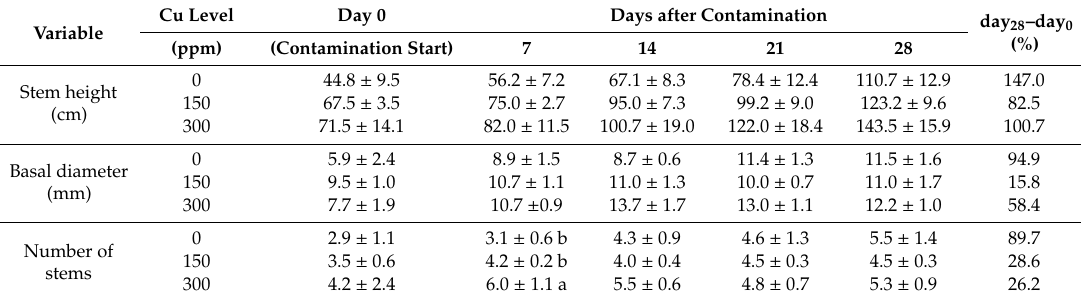
Table 2. Time course of the plant height (main stem length), the number of stems and the basal diameter of the main stem in Arundo plants treated with di ff erent copper concentrations (0, 150, and 300 ppm) for 28 days. The values represent means (n = 4) ± S.E., respectively. One-way ANOVA was applied, and di ff erent letters indicate significant di ff erence according to Tukey test ( p ≤